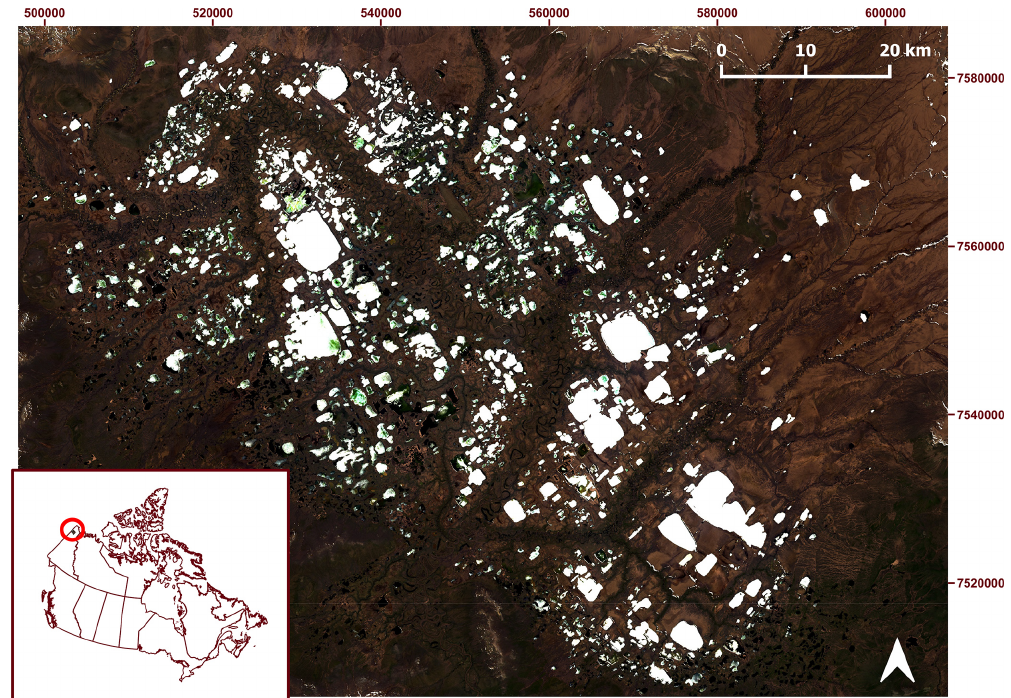
Figure 1. Old Crow Flats, Yukon, Canada. The background image is an RGB Landsat 8 of 31 May 2020, downloaded from USGS Earth Explorer (link: https://earthexplorer.usgs.gov/, last access: 4 July 2021). Most lakes are still ice-covered at this time of the year and appear white; open-water surfaces of the river and smaller lakes as well as some of the ice fringes appear black; tundra has a brownish shade, while areas of boreal forest appear dark green.